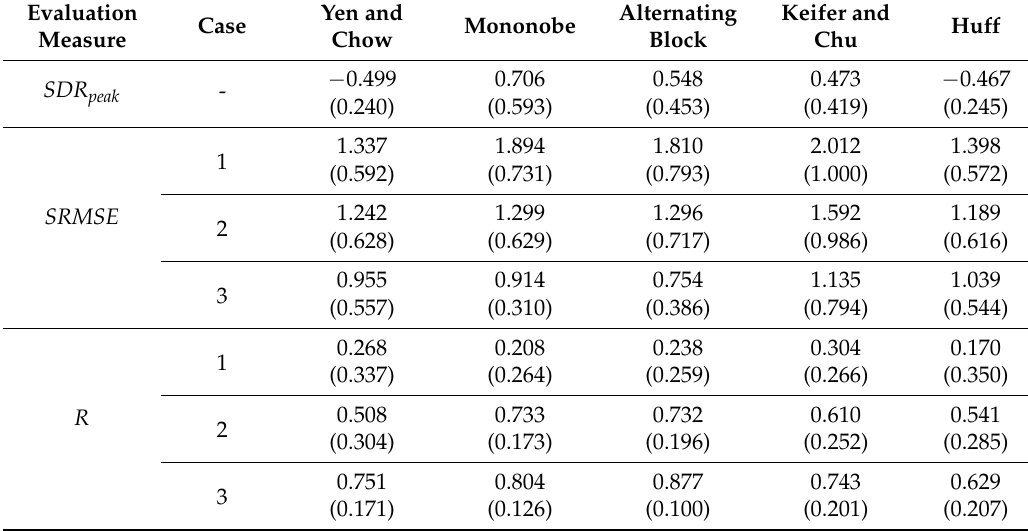
Table 3. Evaluation results of rainfall temporal distribution models with all the annual maximum rainfall events considered in this study (mean value along with standard deviation inside the